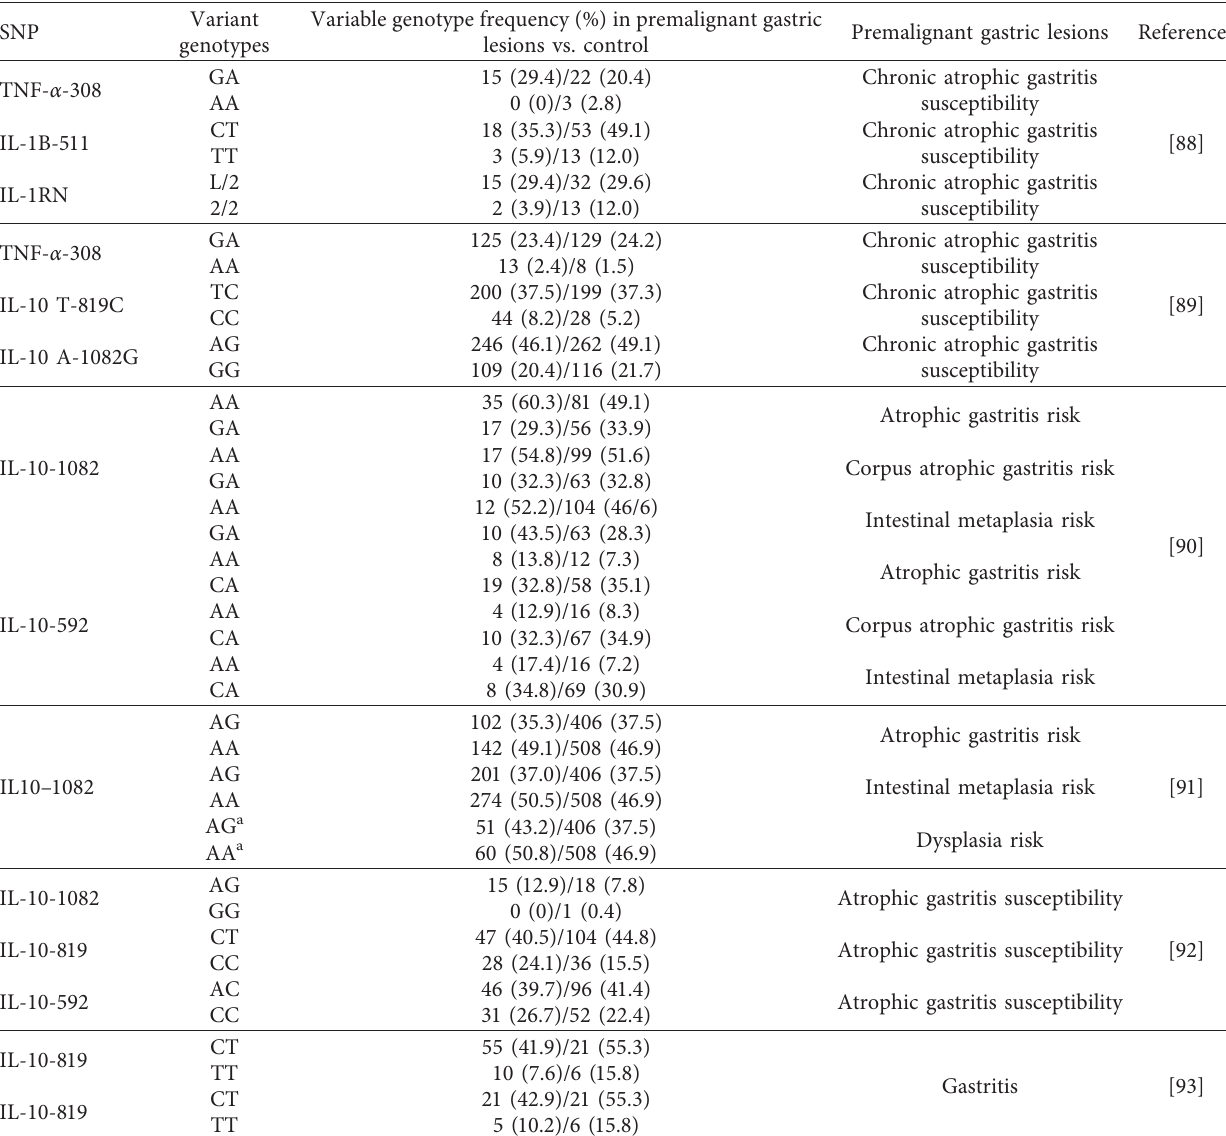
Table 1: Association between frequencies of some important cytokine SNP genotypes and premalignant gastric lesions.